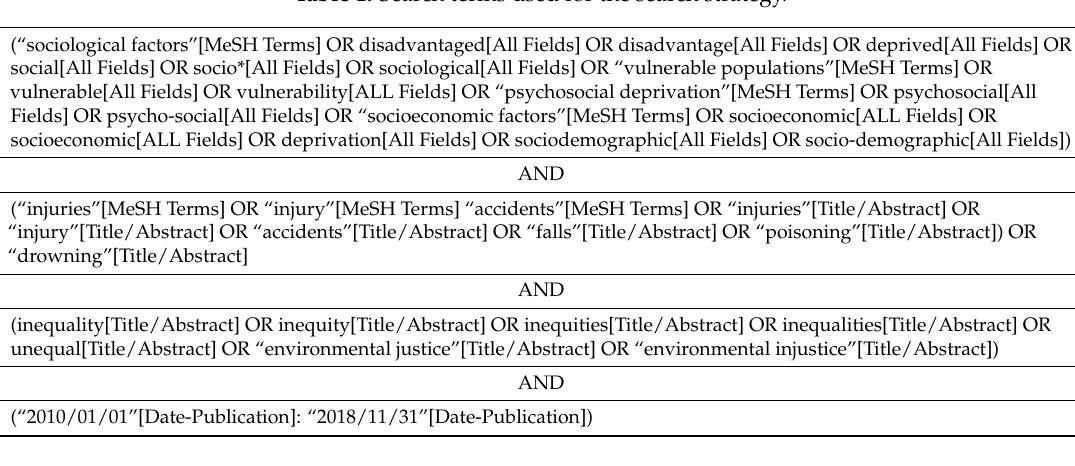
Table 1. Search terms used for the search